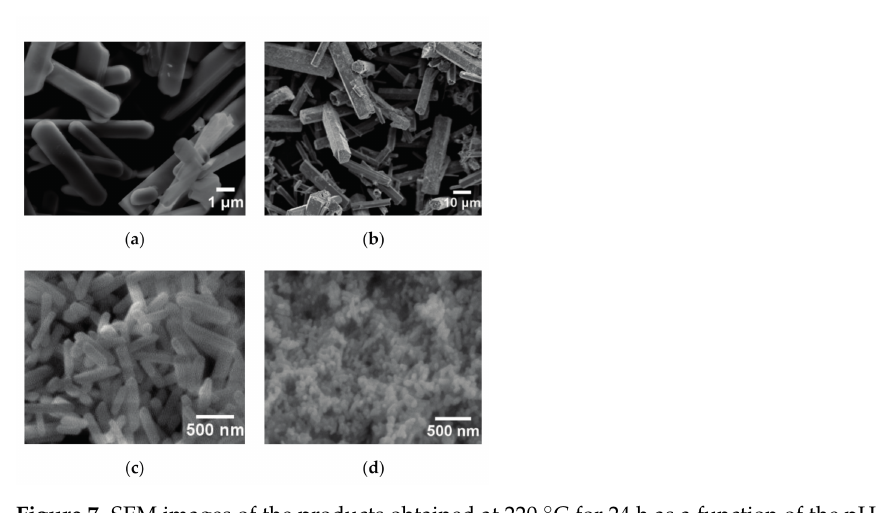
Figure 7. SEM images of the products obtained at 220 ◦ C for 24 h as a function of the pH value of the starting solution. The pH value used is 7.63 ( a ), 9.15 ( b ), 10.90 ( c ), 12 ( d ).